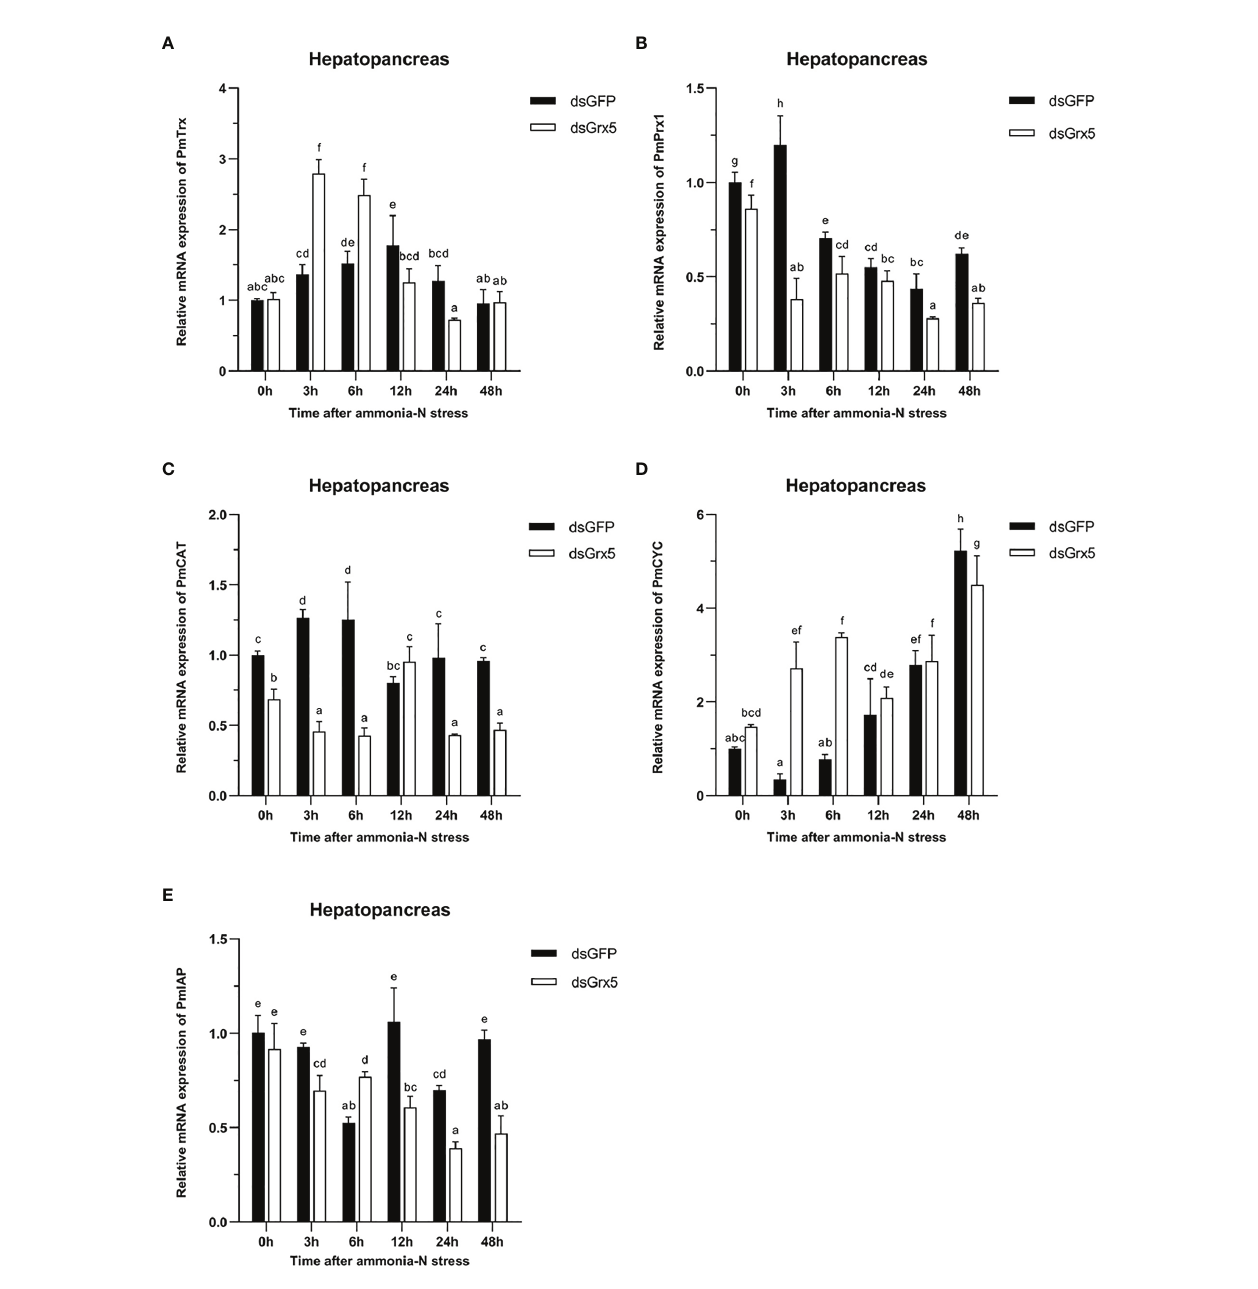
FIGURE 9 | Expression pro fi les of fi ve genes [ PmTrx (A), PmPrx1 (B) , PmCAT (C) , PmCYC (D) , and PmIAP (E) ] in the hepatopancreas of dsRNA-injected shrimps under ammonia-N stress. The data are presented as mean ± SD ( n = 3). Different letters denote signi fi cant differences ( P <